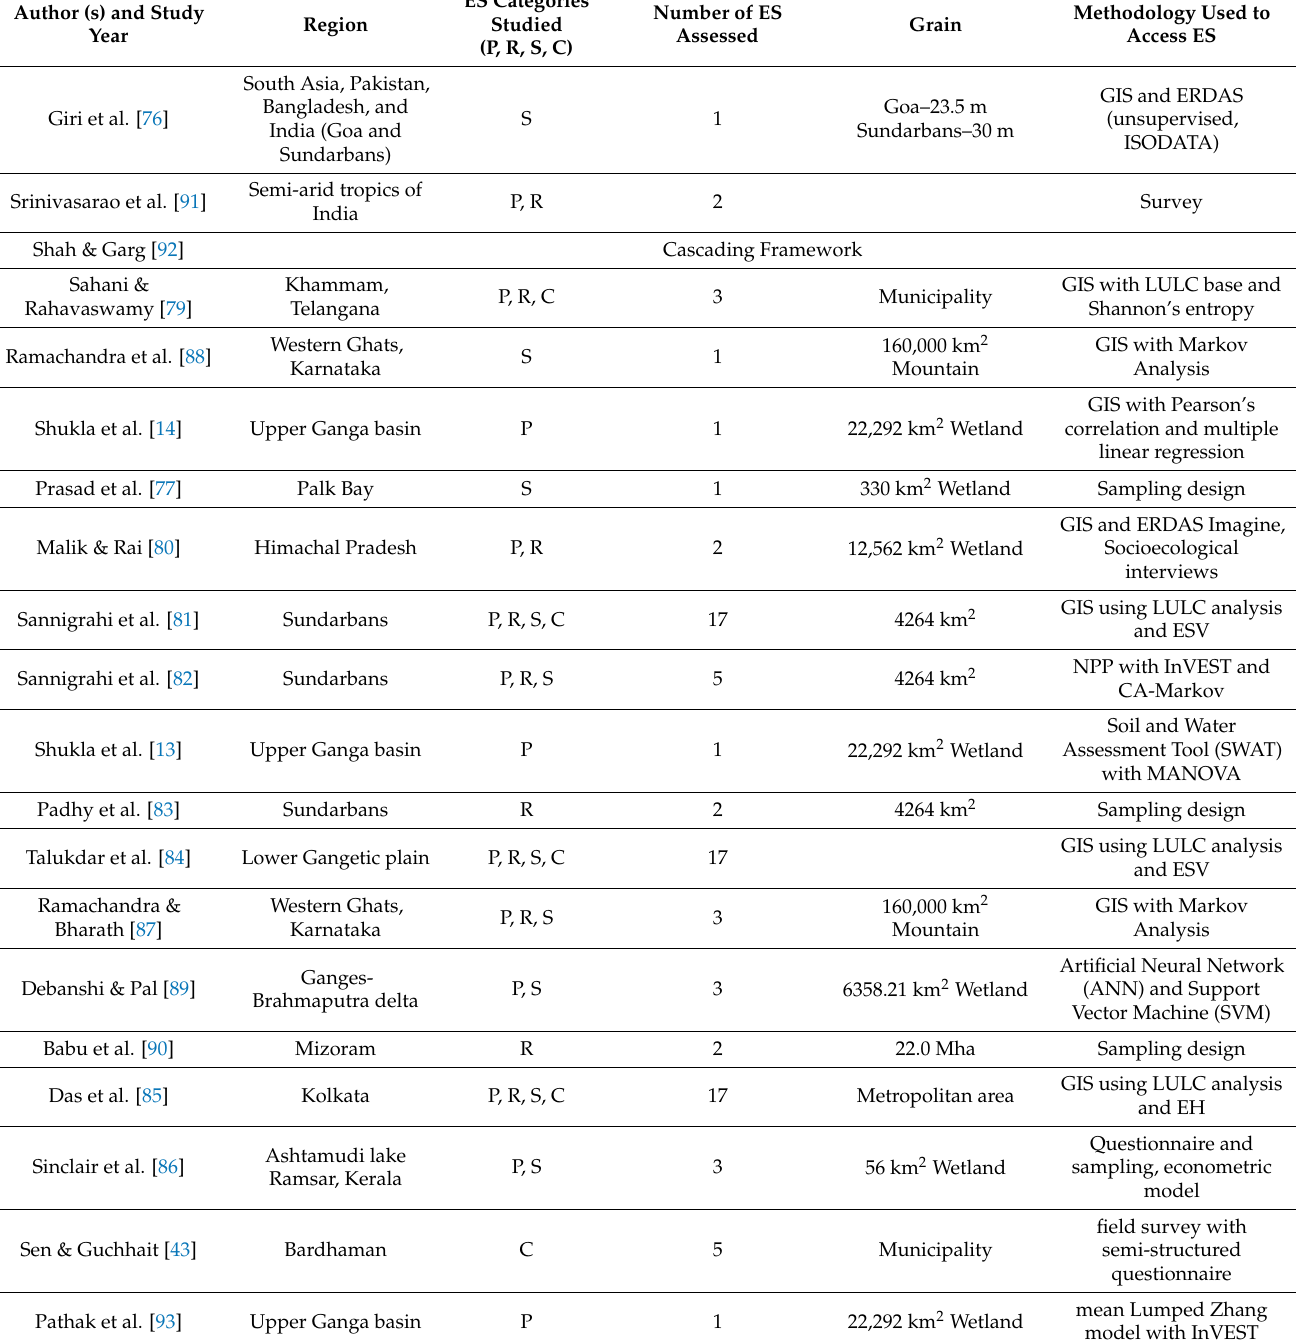
Table 2. Studies conducted on ESs in